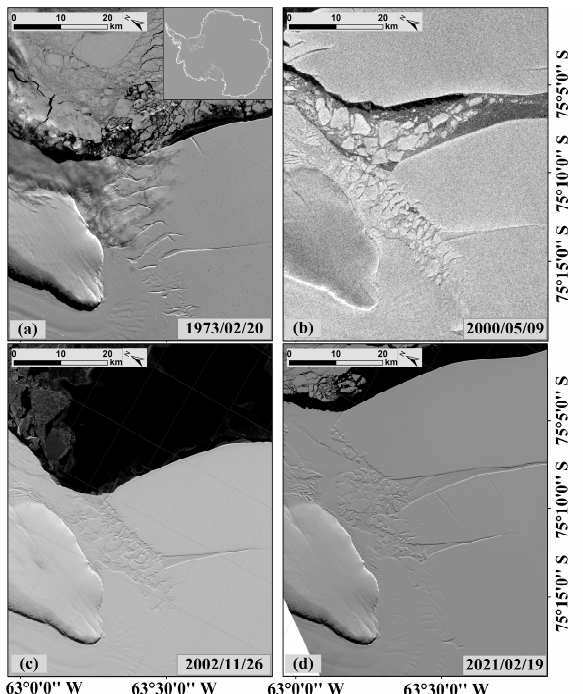
Figure 4. (a) The brown lines demarcate the image object boundaries, and the red lines show the A-76 iceberg boundaries (including A-76A, A-76B, and A-76C). (b) The iceberg borders of A-76A, A-76B, and A-76C are shown by blue dashed lines. Sentinel-1 GRD image data collected on July, 3 2021 in the background.